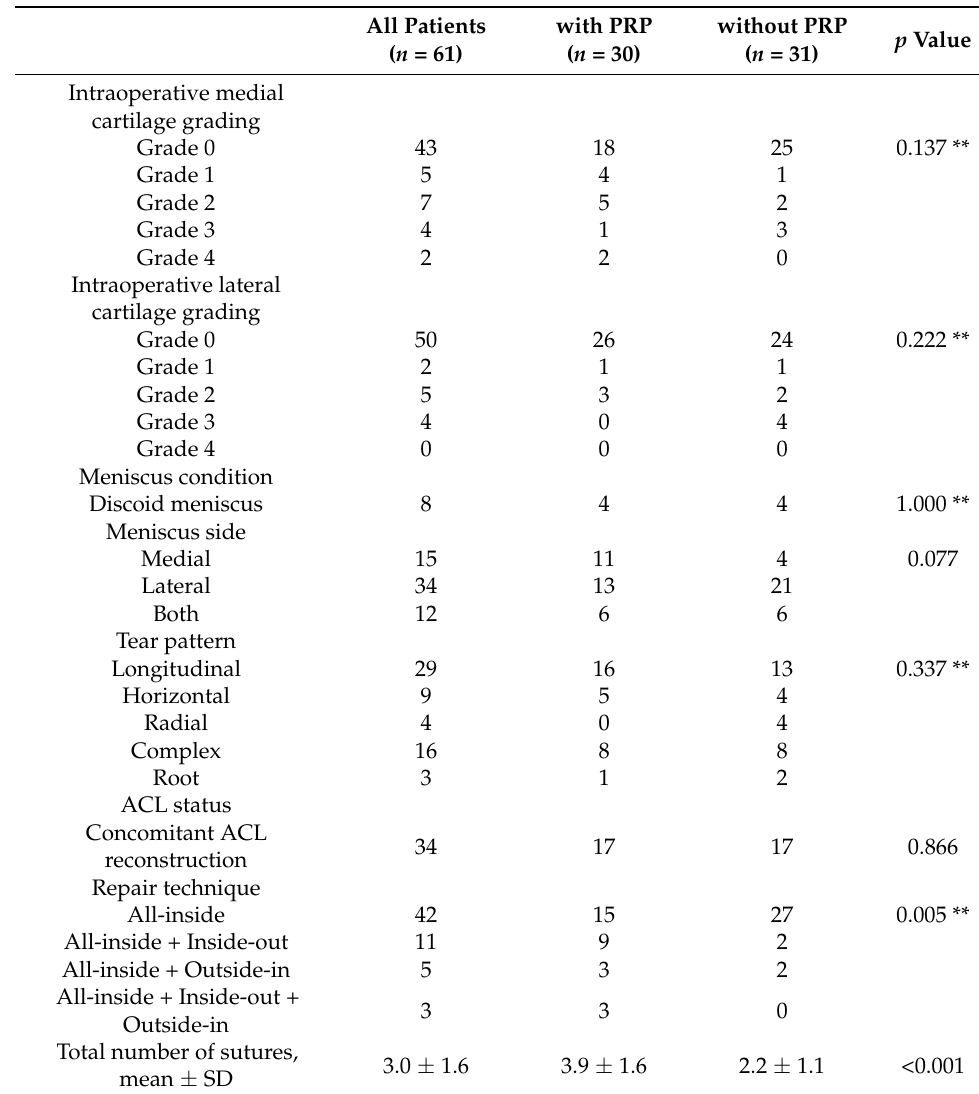
Table 2. Intraoperative